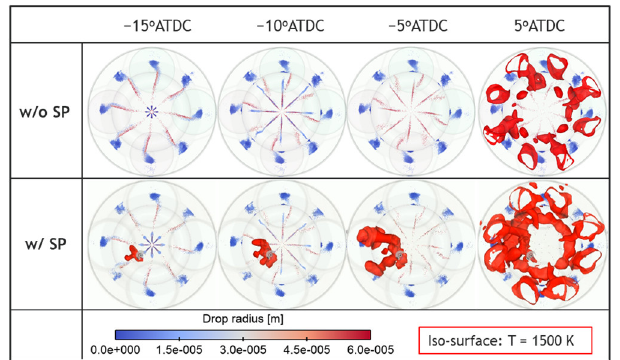
Figure 2. In-cylinder fuel droplet distribution and flame volume development in two cases (w/o SP and w/SP) under cold idle operation in an HD GCI engine.